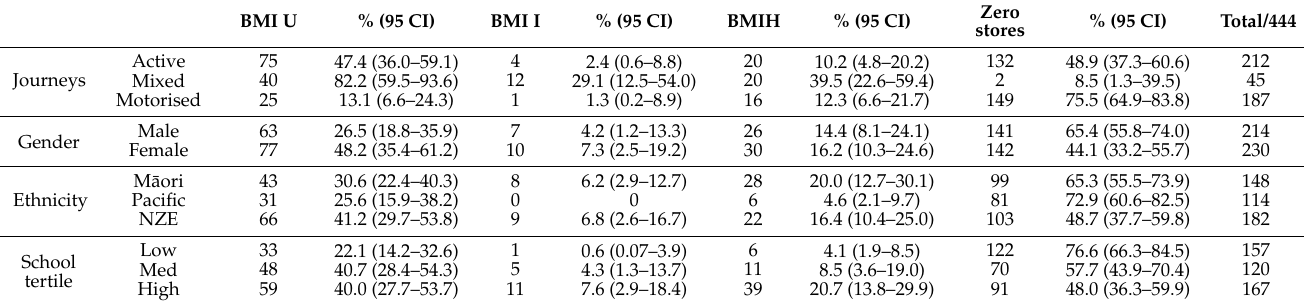
Table 3. Exposure to food outlet category, by travel mode and demographic